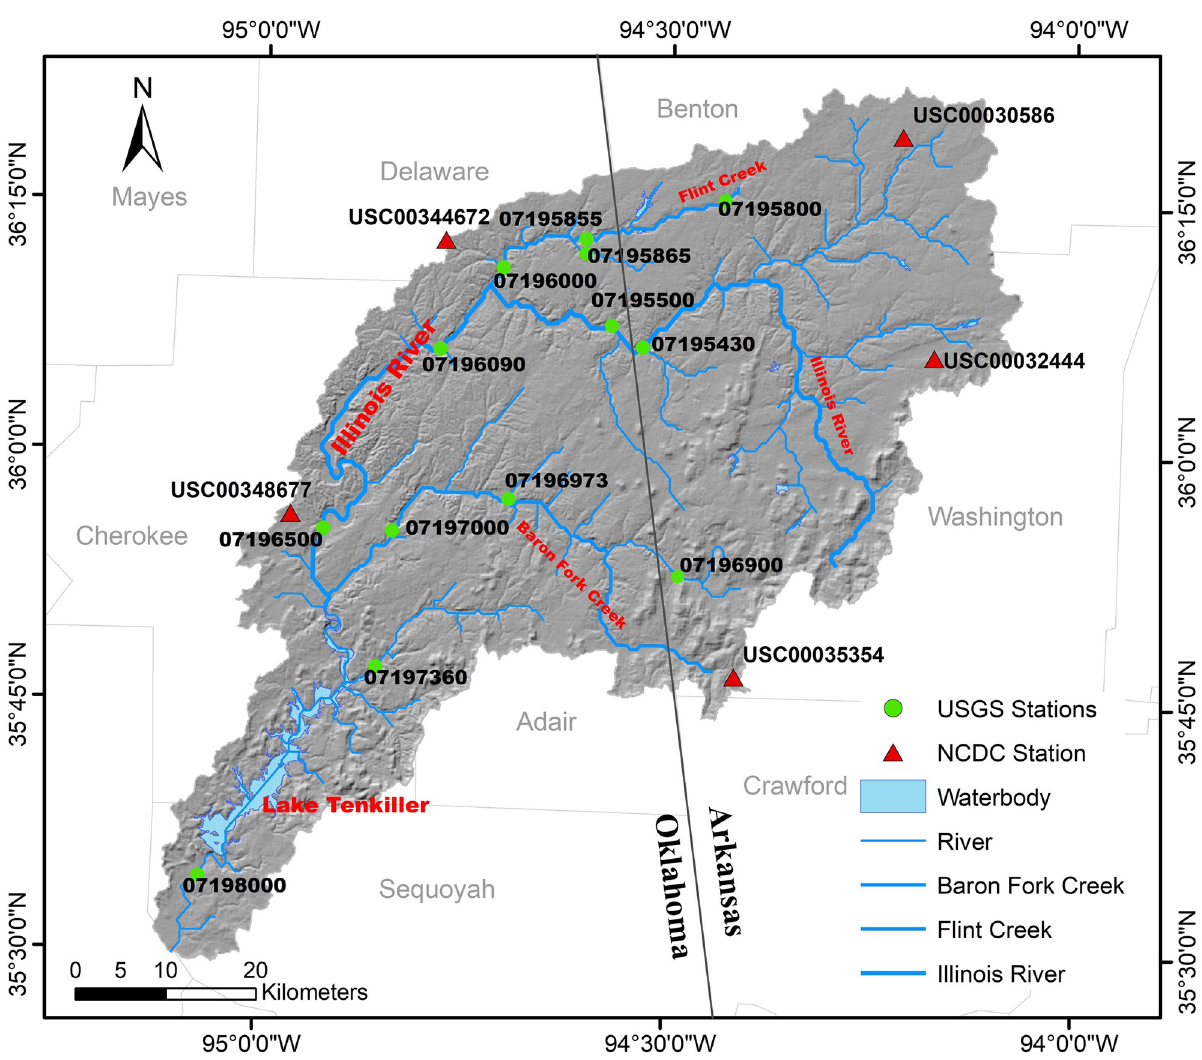
Fig 1. The geographic position of USGS hydrological stations, NCDC meteorological stations, and principal rivers in the IRW.